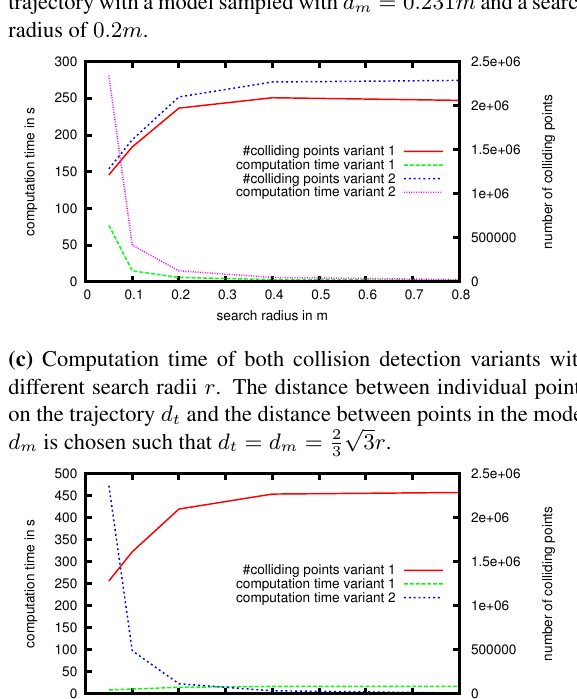
√ 3 r . Colliding points 3